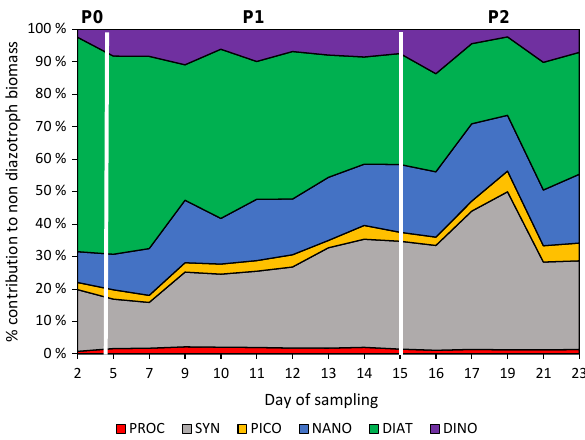
Figure 10. Dynamics of the biomass of the main groups con- stituting phytoplankton communities in biomass (diazotrophs not Figure 10 : Dynamics of the biomass of the main groups constituting phytoplankton communities included) over the course of the experiment for Prochlorococ- (diazotrophs not included) over the course of the experiment for Prochlorococcus (PROC), Synechococcus (SYN), pico-phytoeukaryotes (PICO), nano-phytoeukaryotes (NANO), diatoms (DIAT) and dinoflagellates cus (PROC), Synechococcus (SYN), picophytoeukaryotes (PICO), (DINO). nanophytoeukaryotes (NANO), diatoms (DIAT) and dinoflagellates